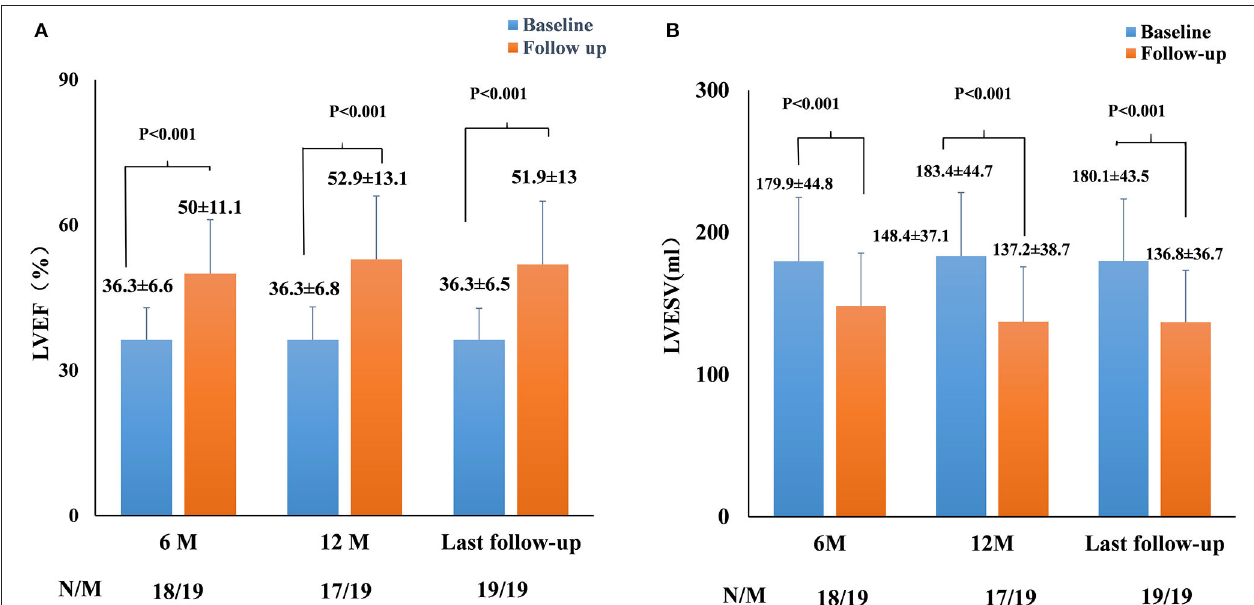
FIGURE 2 | Paired left ventricular ejection fraction (LVEF) (A) and left ventricular end-systolic volume (LVESV) (B) in all pacing-induced cardiomyopathy (PICM) patients at implant and during the median 12-month follow-up. N , the number of patients who had completed the follow-up of 6 and 12 months; M , the number of patients who completed the follow-up of 6 and 12 months. Data were available in 18/19 patients at 6-month follow-up, in 17/19 patients at the 12-month follow-up, and in 19/19 patients at the median 12-month follow-up.